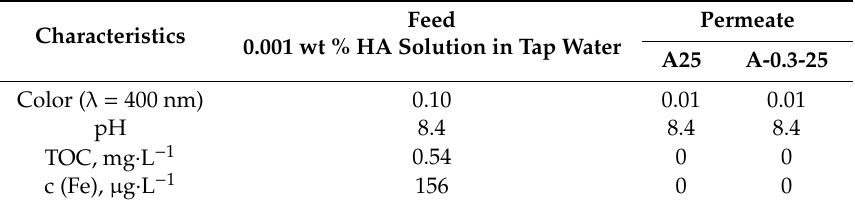
Table 4. Characteristics of feed and permeate upon ultrafiltration of humic acid solution.